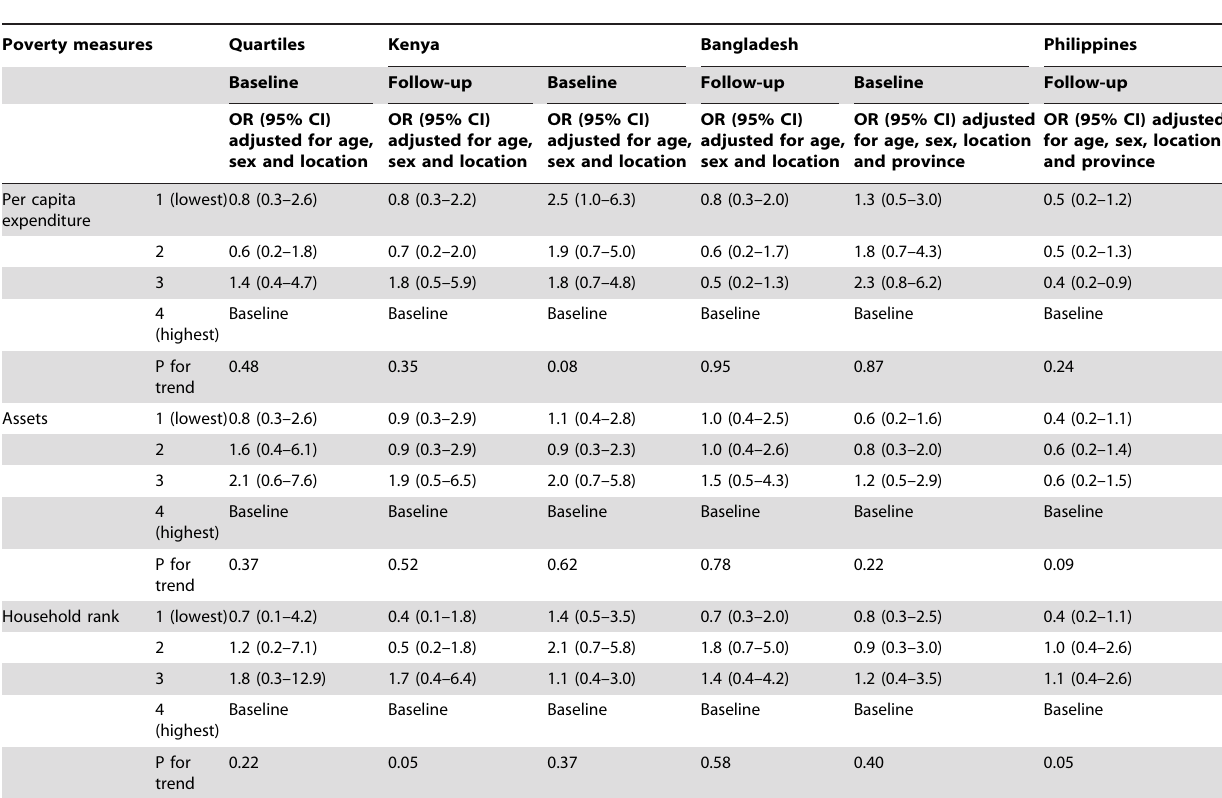
Table 5. Multivariable analyses for the comparison of poverty variables at baseline and follow-up among operated cases and unoperated